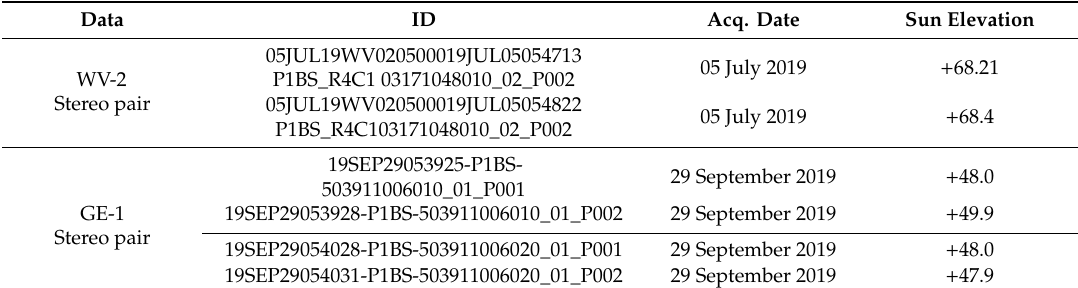
Table A3. Details for GE-1 and WV-2 satellites images used for DEM generation over Shisper glacier study